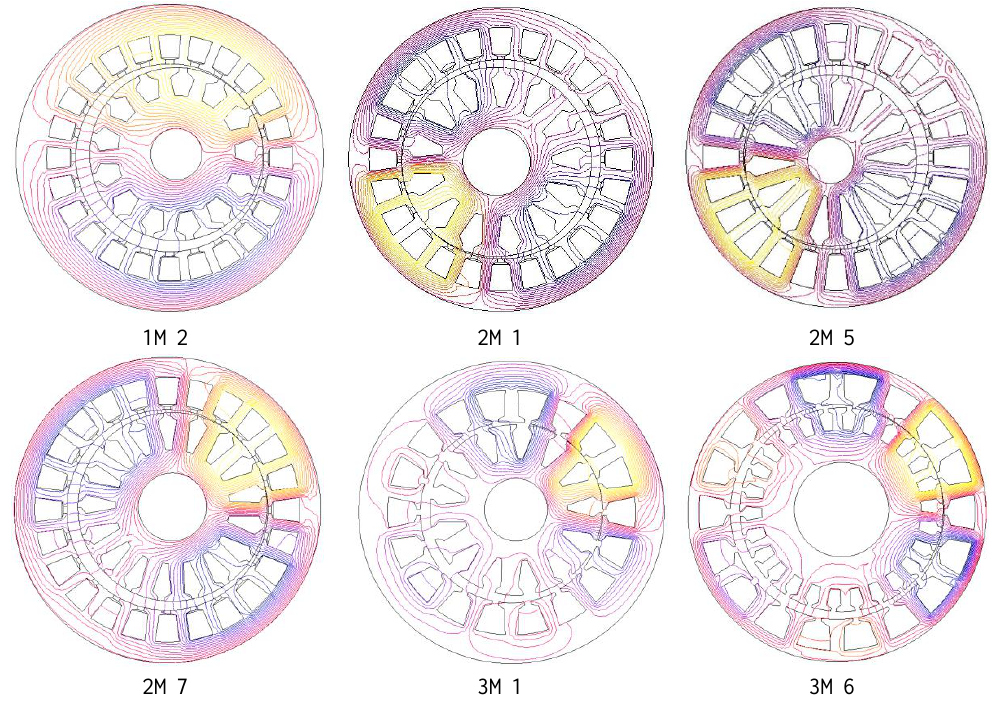
Figure 9. Flux lines in the iron core of the ZAIMs with e = 1.5 mm.